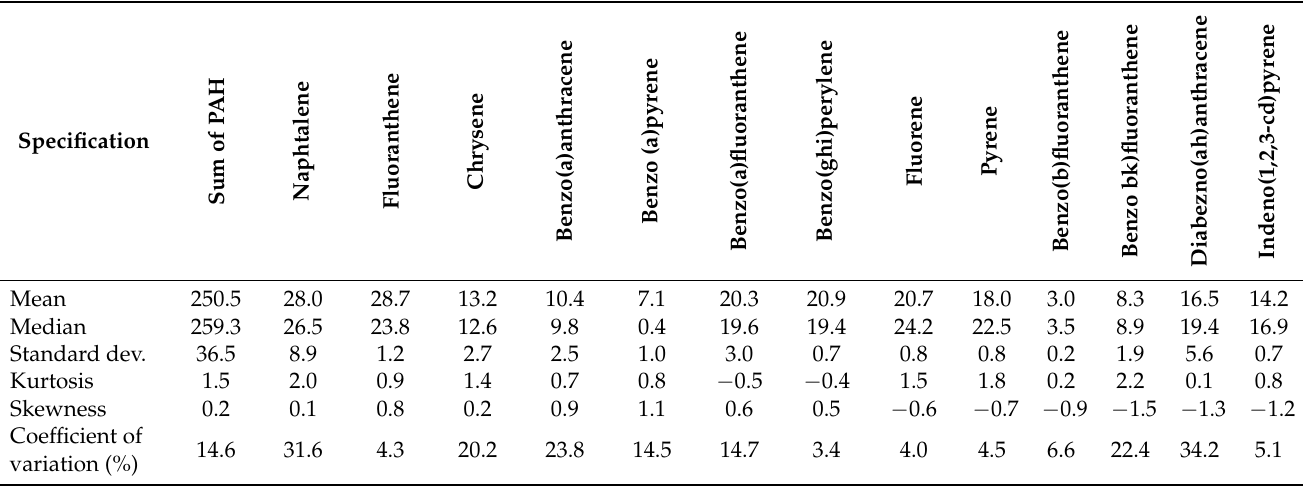
Table 6. Descriptive statistics of polycyclic aromatic hydrocarbons (PAH) content in the soil before the start of the research ( µ g kg − 1 ).